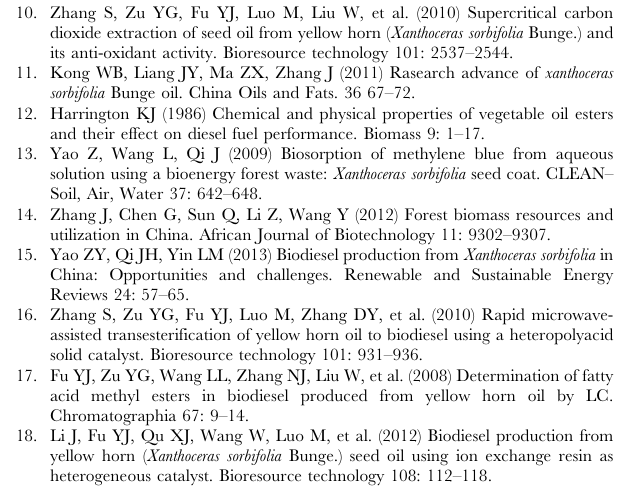
Table S3 Putative transcription factors encoding unigenes in yellow horn. Table S4 SSRs located in unigenes related to oil biosynthesis and metabolism. Table S5 SNPs located in unigenes related to oil biosynthesis and metabolism. Table S6 InDels located in unigenes related to oil biosynthesis and